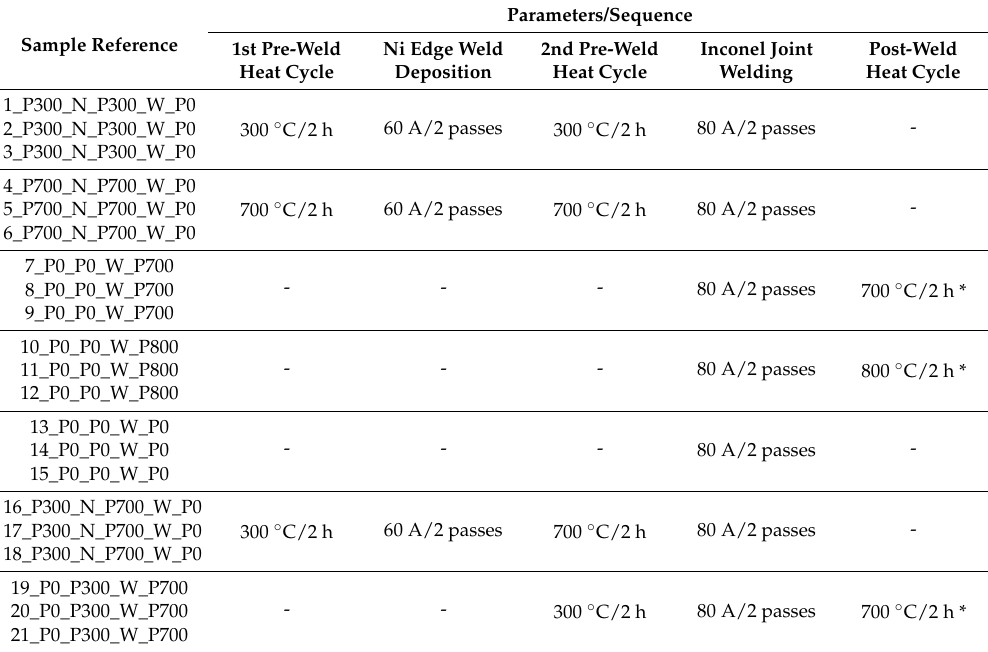
Table 2. Specific parameters used for each sample group during the creation of test